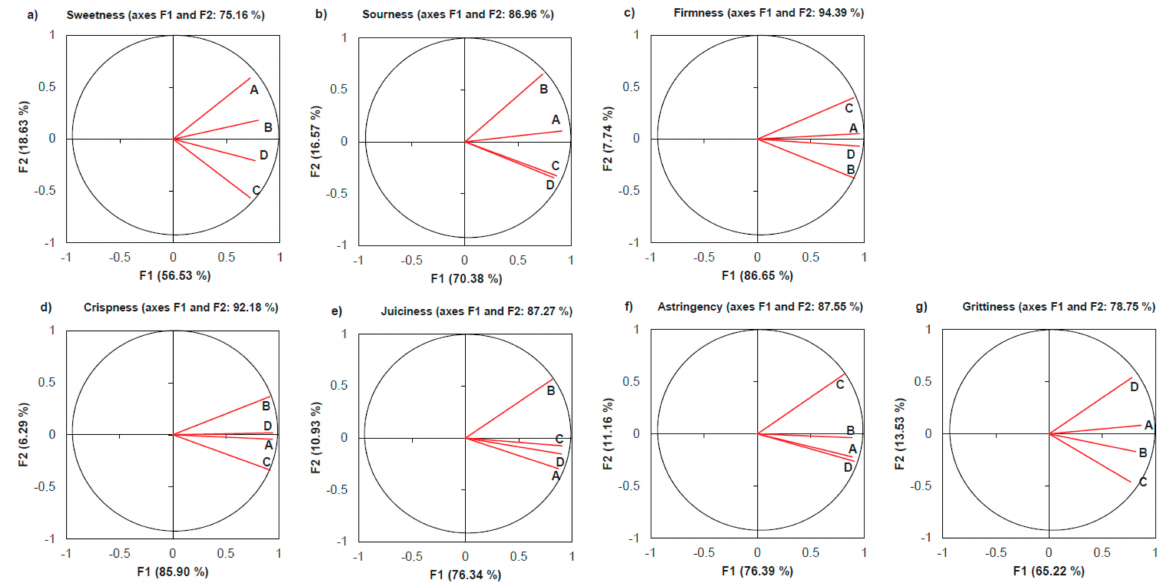
Figure 2. Loading plot F1 versus F2 of the principal components analysis models of each sensory attribute, ( a ) for sweetness, ( b ) for sourness, ( c ) for firmness, ( d ) for crispness, ( e ) for juiciness, ( f ) for astringency and ( g ) for grittiness, with the samples characterised by the scores of each expert panellist (four experts: A, B, C, D; samples n =